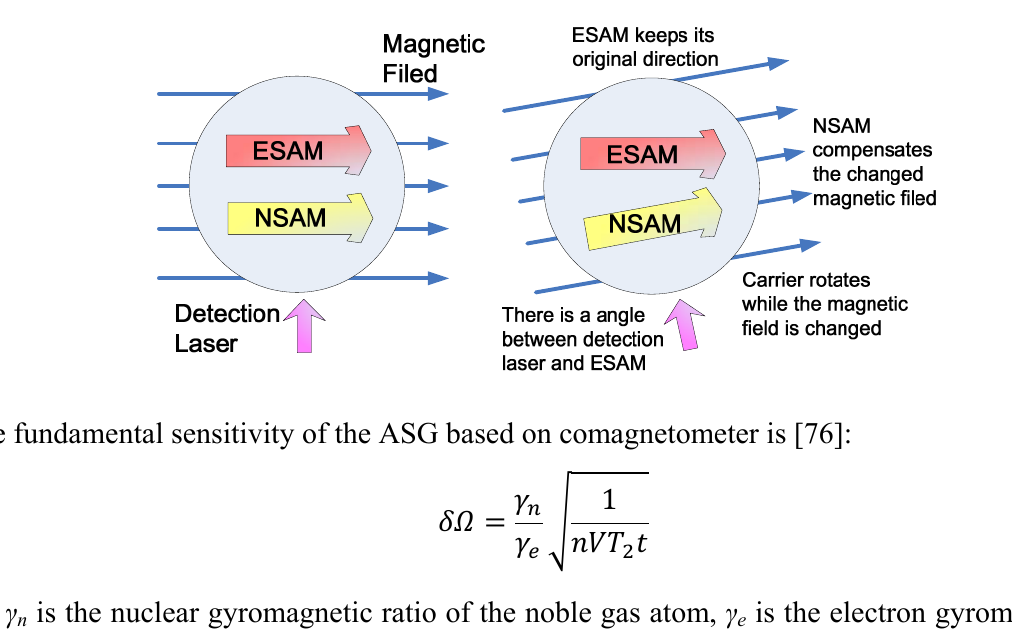
Figure 3. Principle of ASG based on